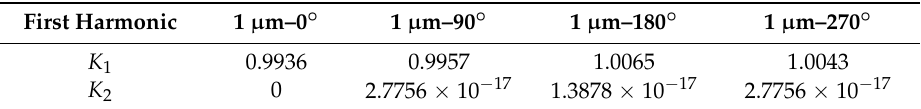
Table 3. The linear model of the HRG output.